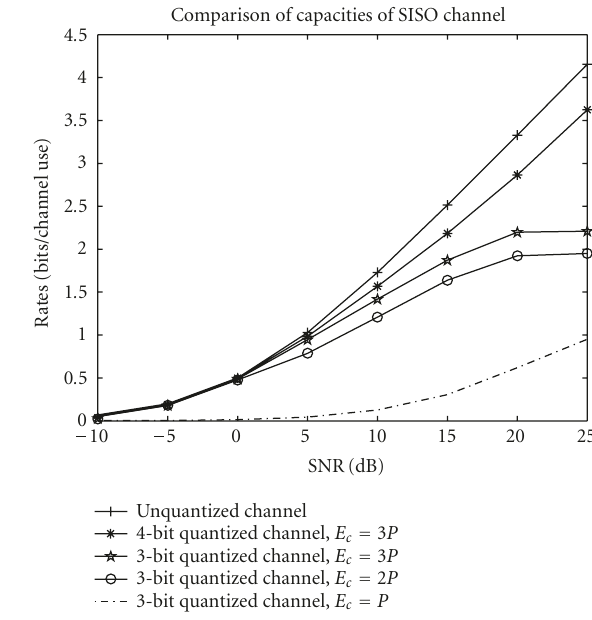
Figure 5: Comparison of capacity versus nominal SNR for di ff erent SISO